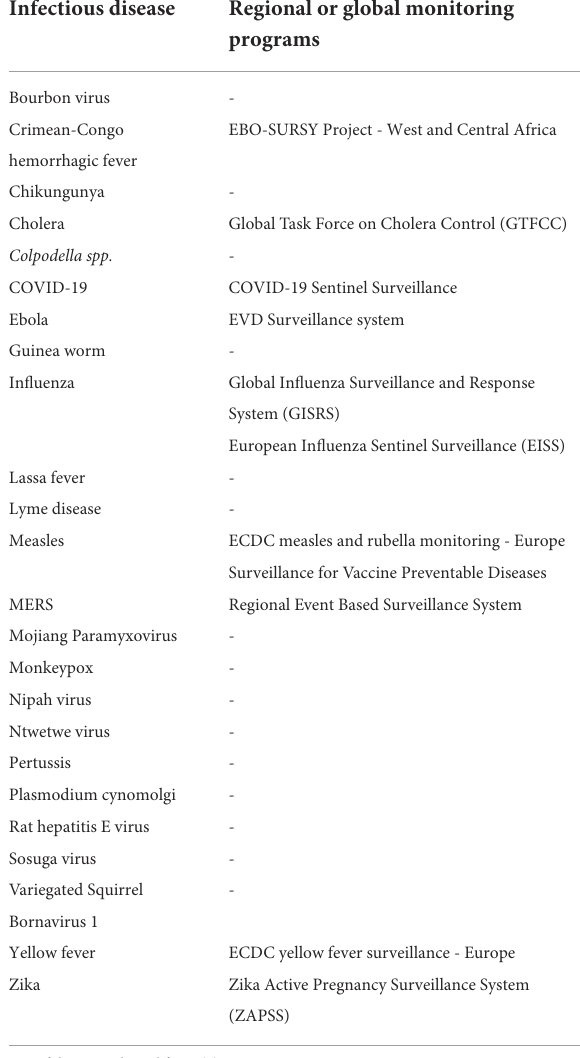
TABLE 1 Examples of long-term, continuous, regional, and global programs used for monitoring infectious diseases. Infectious